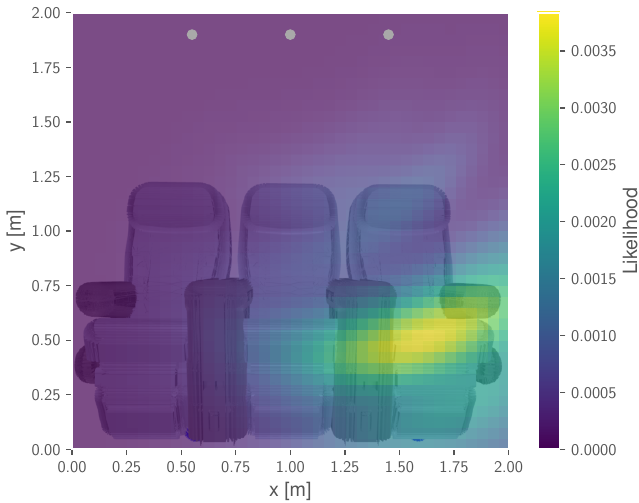
Figure 8. Exemplary probability mapping output for a seat occupancy detection scenario.